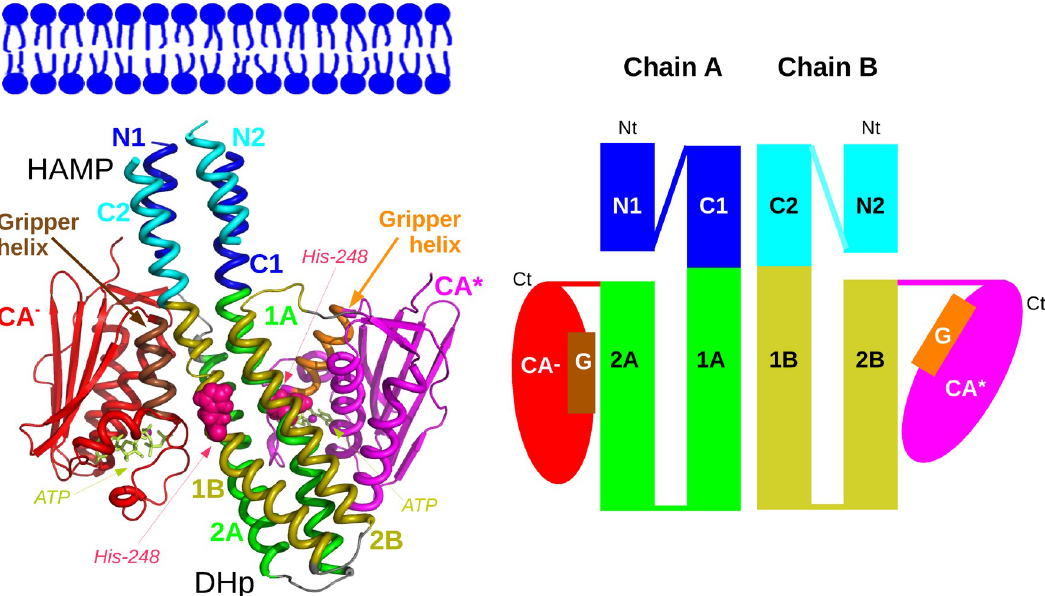
Fig 1. X-ray crystallographic structure of CpxA. Left panel. X-ray structure 4BIV [26] of CpxA shown in cartoon using PyMOL [62]. The approximate position of the membrane is indicated at the top of the figure. The loops of residues 202-218 connecting the HAMP helices are not shown for a sake of clarity. The α helices of HAMP and DHp and the CA domains used for defining the collective variables, are differently colored, in blue (chain A) and cyan (chain B) in HAMP and in green (chain A) and yellow (chain B) in DHp. The domain CA − (red) (chain A) is moved apart from H248 in order to allow the transfer of phosphate group to the response regulator, whereas the domain CA � (magenta) (chain B) is in autokinase configuration, close to H248. The H248 are drawn in CPK and colored in purple, the ATP molecules are drawn in sticks and colored in lime. The gripper helices (residues 420-430 in domains CA � and CA − ) are colored respectively in orange and brown. Right panel. Schematic representation of CpxA dimer: the HAMP and DHp α helices and the domains CA are represented with the same names and color-code than in the left panel. The gripper helices are labeled with the letter G. The N terminal and C terminal extremities are indicated with labels Nt and Ct.